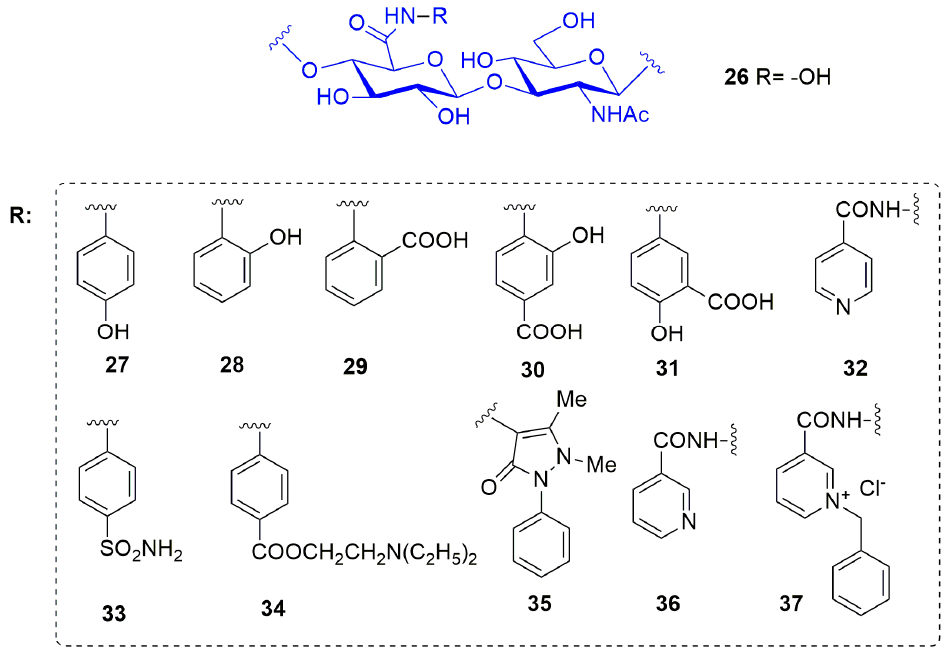
Figure 9. Chemical structure of hyaluronic acid-based MMP-2 inhibitors